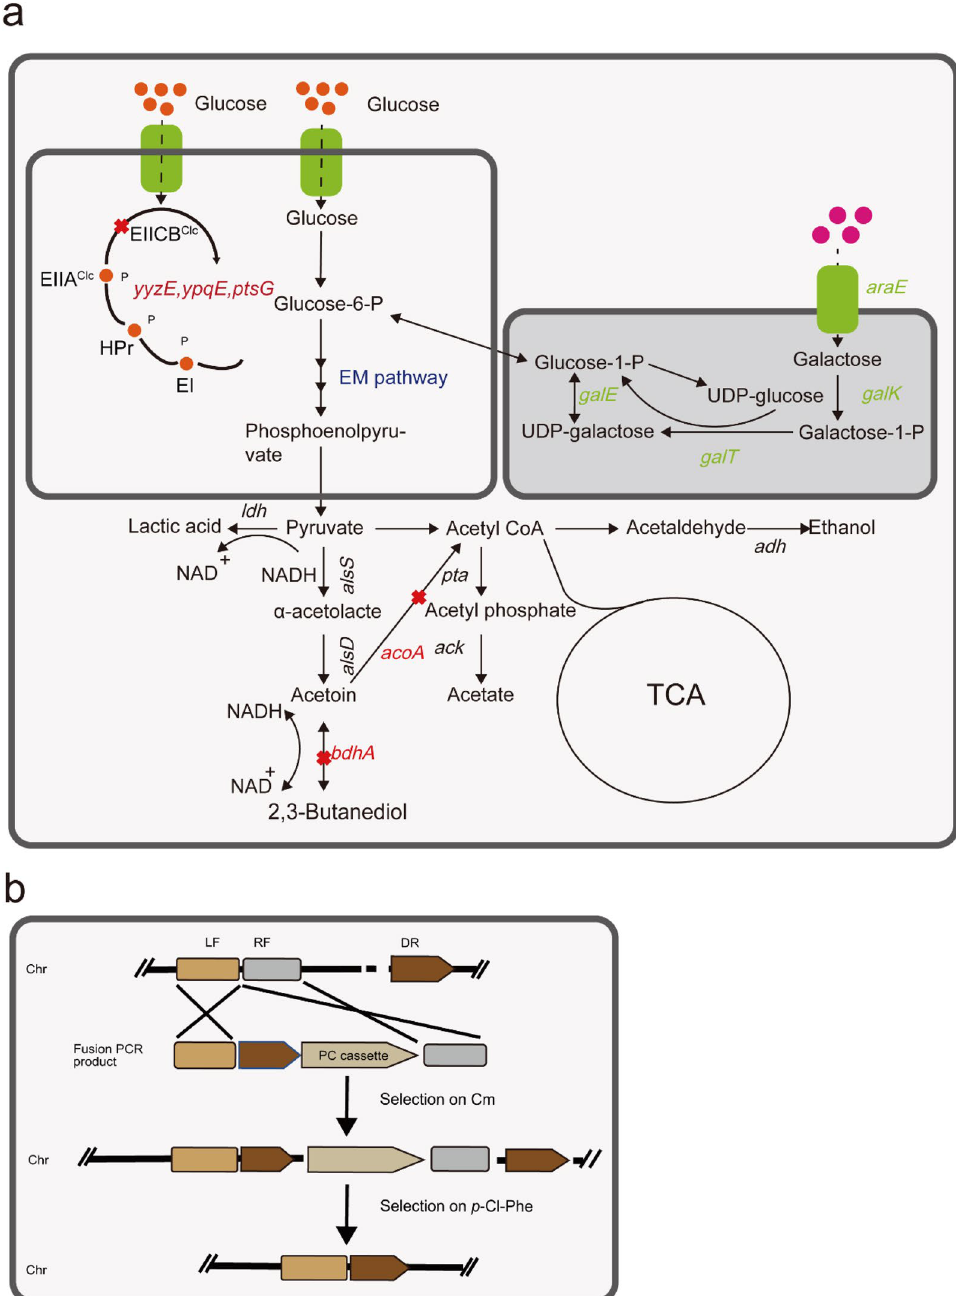
Fig. 1 a Overview of the production of TTMP from a mixture of glucose and galactose by B. subtilis engineered bacteria. Green words represent genes expressed on plasmid pMA5. Red words represent knockout genes. b pheS * counter-screening marker gene knockout